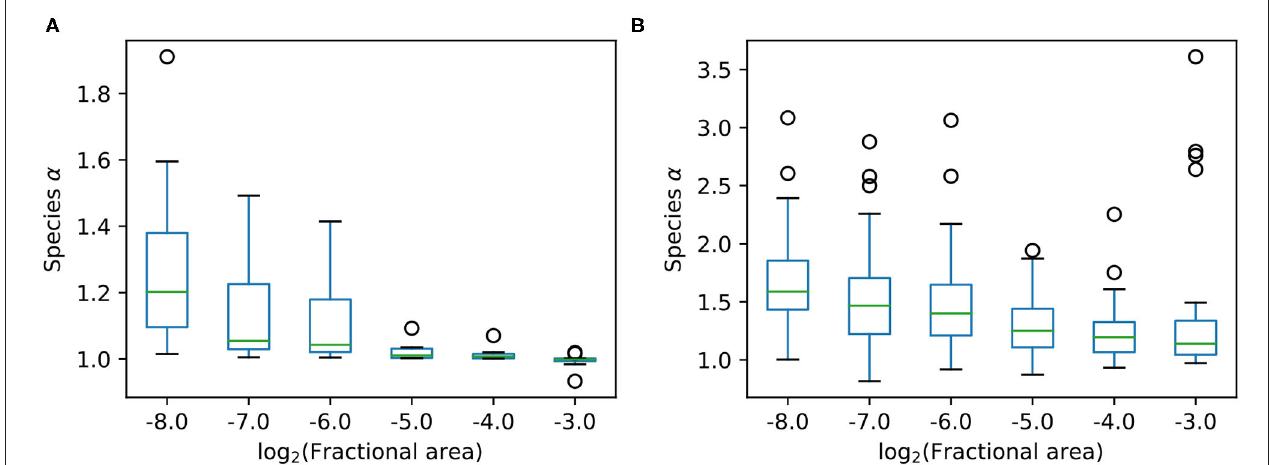
FIGURE 2 | Boxplots for α among the species at different scales at both sites, where panel (A) shows 10 species from the Serpentine dataset, and panel (B) shows 40 species from the BCI dataset. In both cases at smaller scales α is larger, and we see a relatively large spread in α across species at the same scale. The boxplots show boxes from quartile 1 (Q1) to quartile 3 (Q3) with a line at the median. The whiskers extend to 1.5